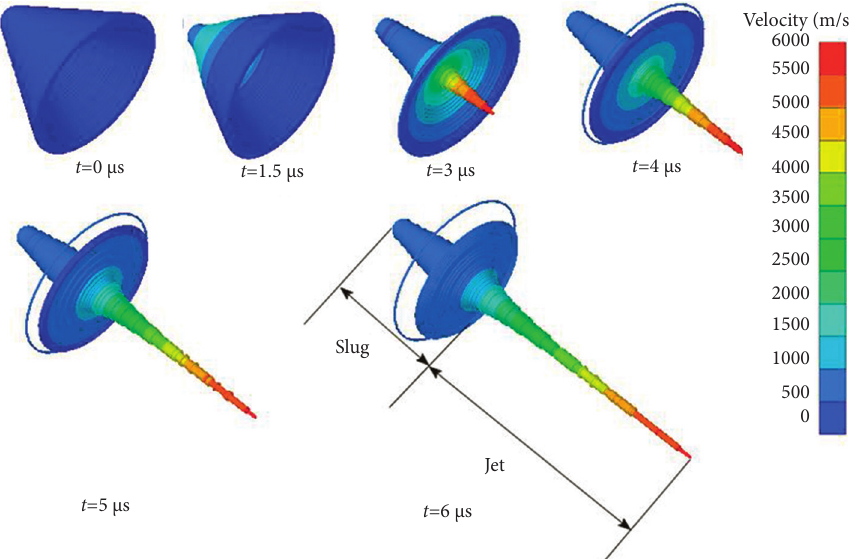
Figure 3: Micro-jet forming process of copper material liner.